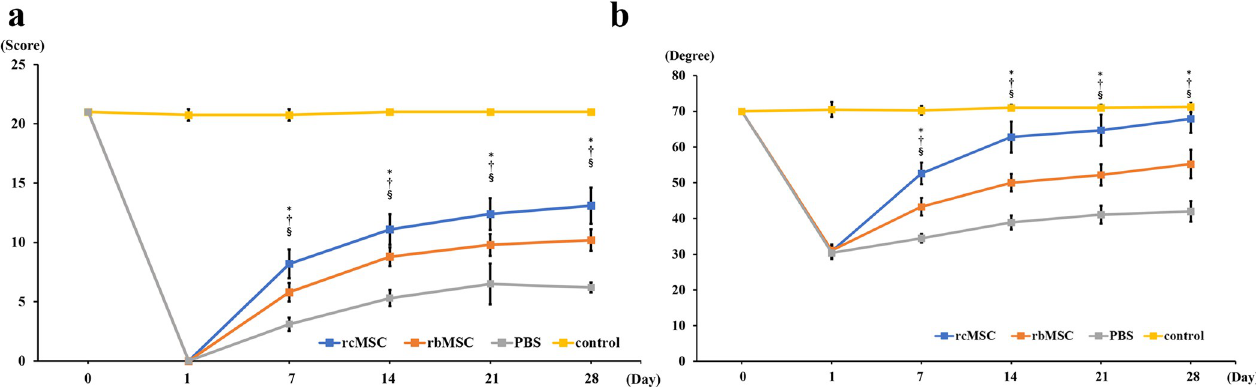
Fig 2. Motor function recovery after spinal cord injury. a. Results of the Basso–Beattie–Bresnahan (BBB) scale and b. inclined plane task score. Data are presented as mean ± standard deviation; n = 4, 10, 10, and 10 for the control, phosphate buffered saline (PBS), rat bone marrow-derived mesenchymal stem cell (rbMSC), and rat cranial bone-derived mesenchymal stem cell (rcMSC) groups, respectively. � P < 0.05, PBS group vs. rcMSC group; †P < 0.05, PBS group vs rbMSC group; §P < 0.05, rcMSC group vs. rbMSC group.